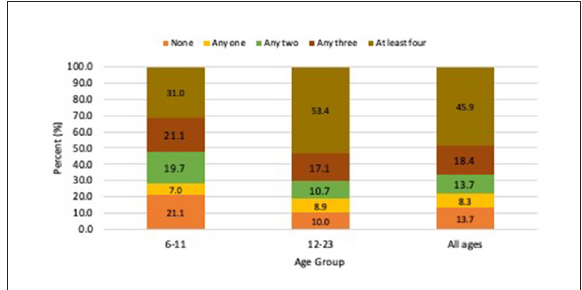
FIGURE1 Minimum dietary diversity among children aged 6–23 months.